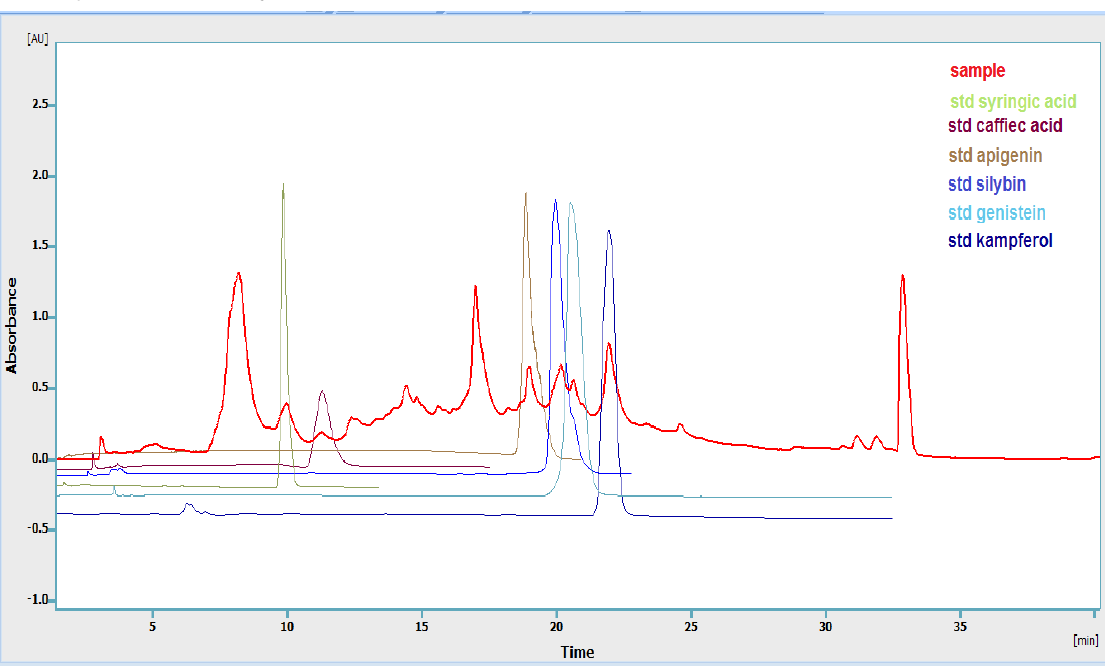
Figure 4. HPLC chromatogram for ethyl acetate fraction (ETA) matched with six detected standards chromatograms.